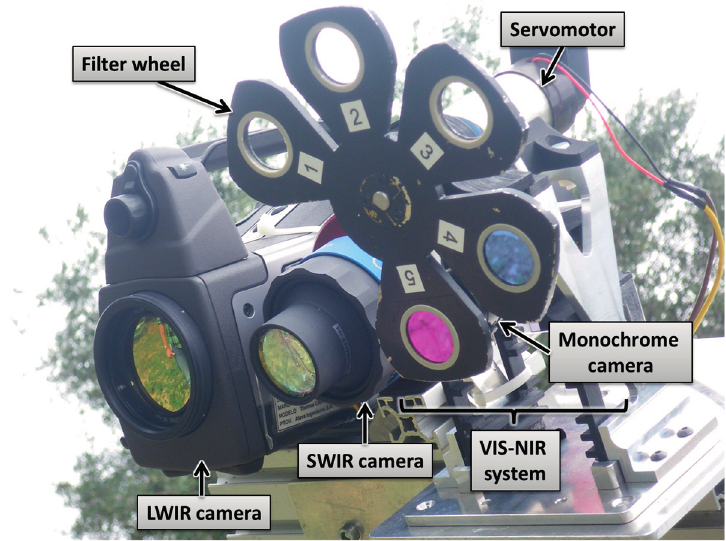
Figure 1. Proposed multisensory